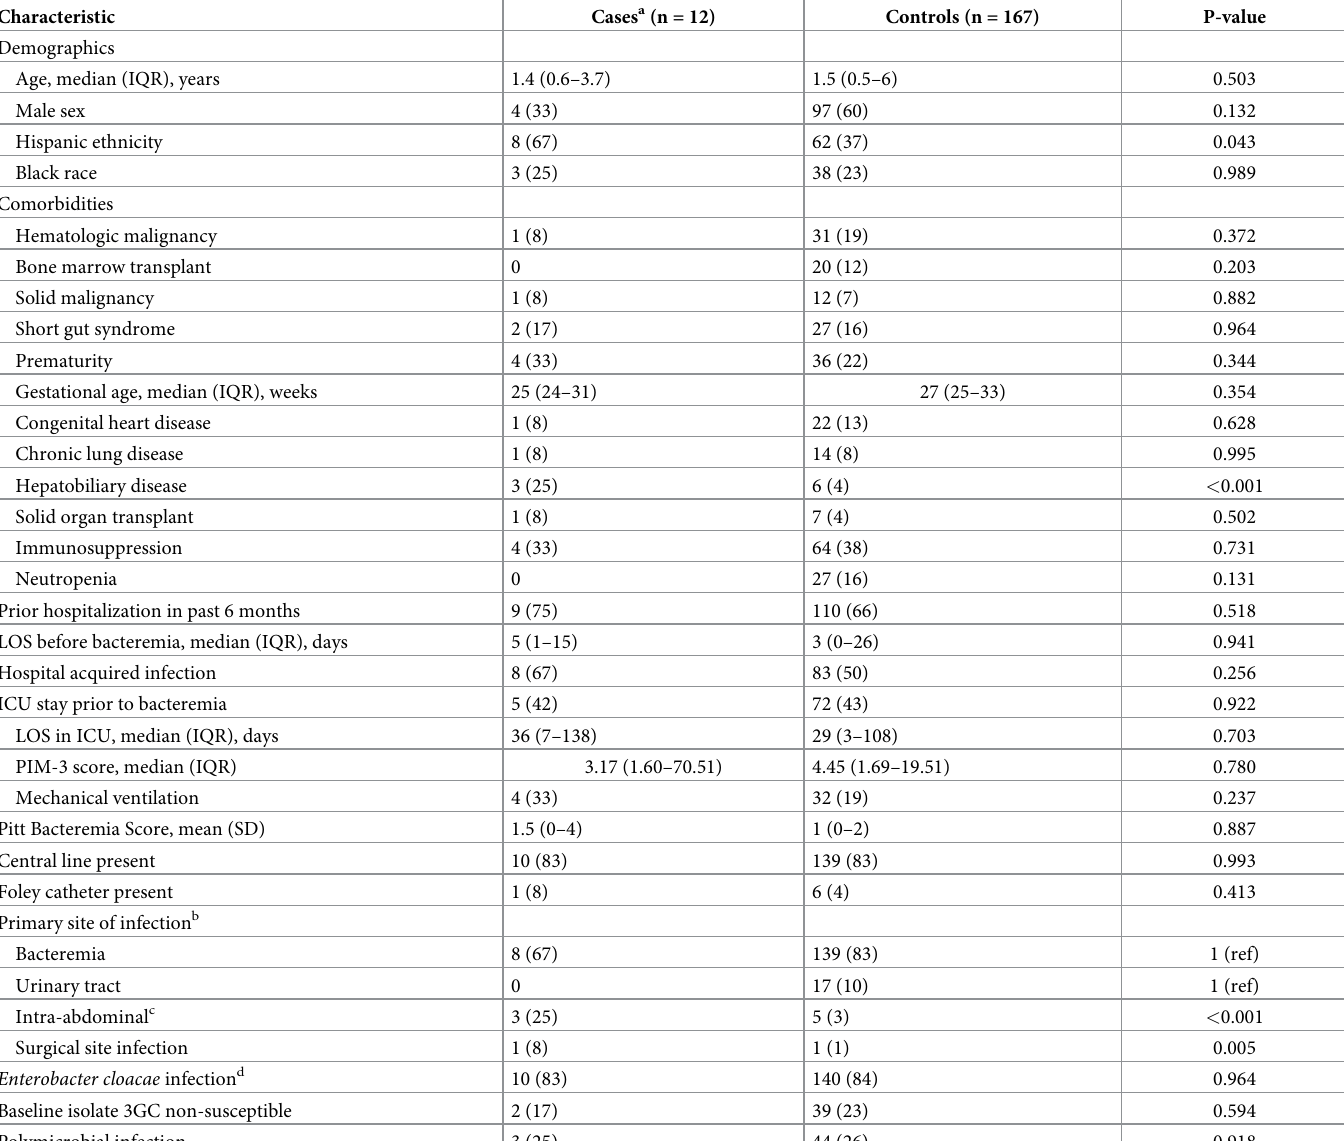
Table 1. Demographic and clinical risk factors for microbiologic failure in children with Enterobacter bacteremia and bivariable analysis.